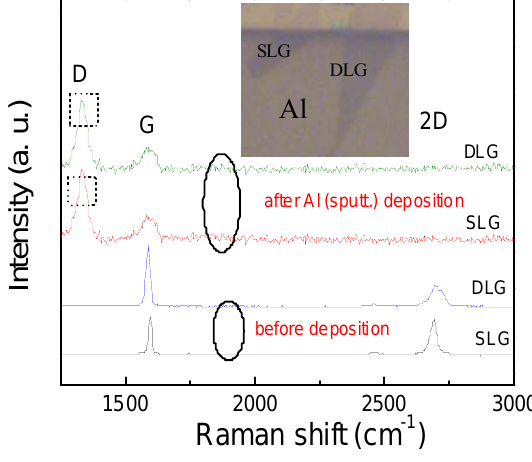
Figure 6. The Raman spectra of SLG, DLG before and after sputtered Al. The optical image of measured Al/SLG, Al/DLG contacts is presented in the